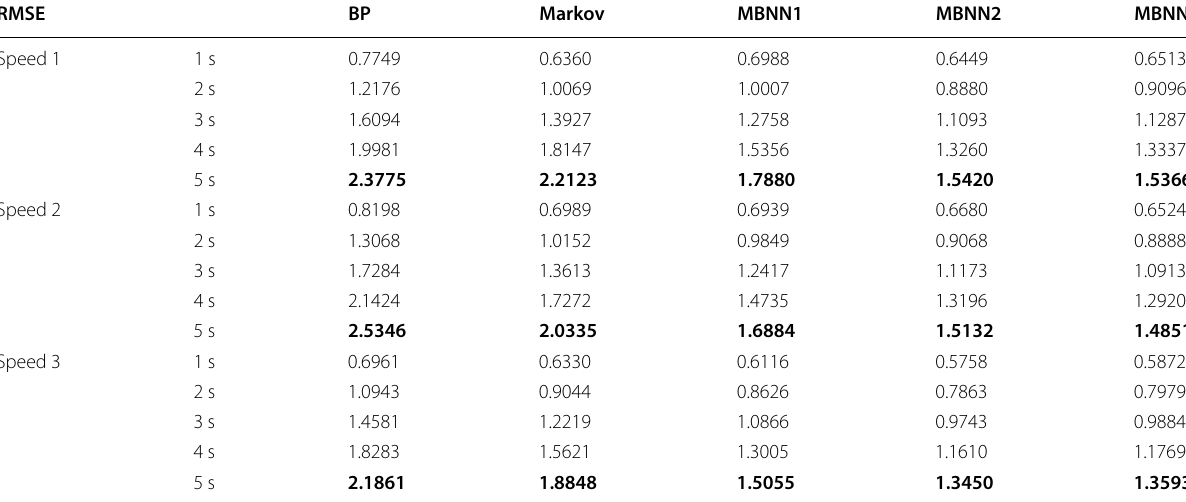
Table 2 The RMSE assessment of the five prediction models (m/s) RMSE BP Markov